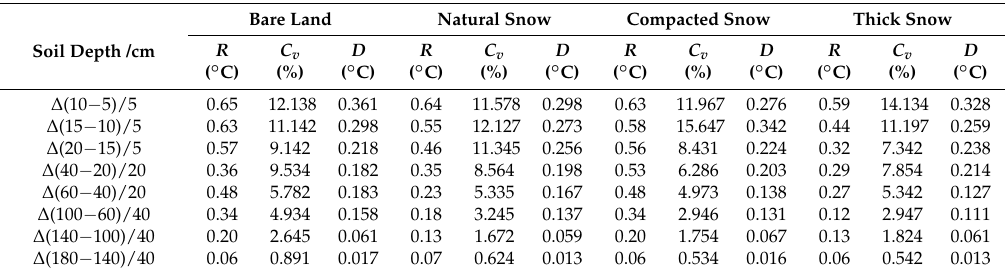
Table 4. Analysis of soil temperature variability in unit soil layers under different snow cover